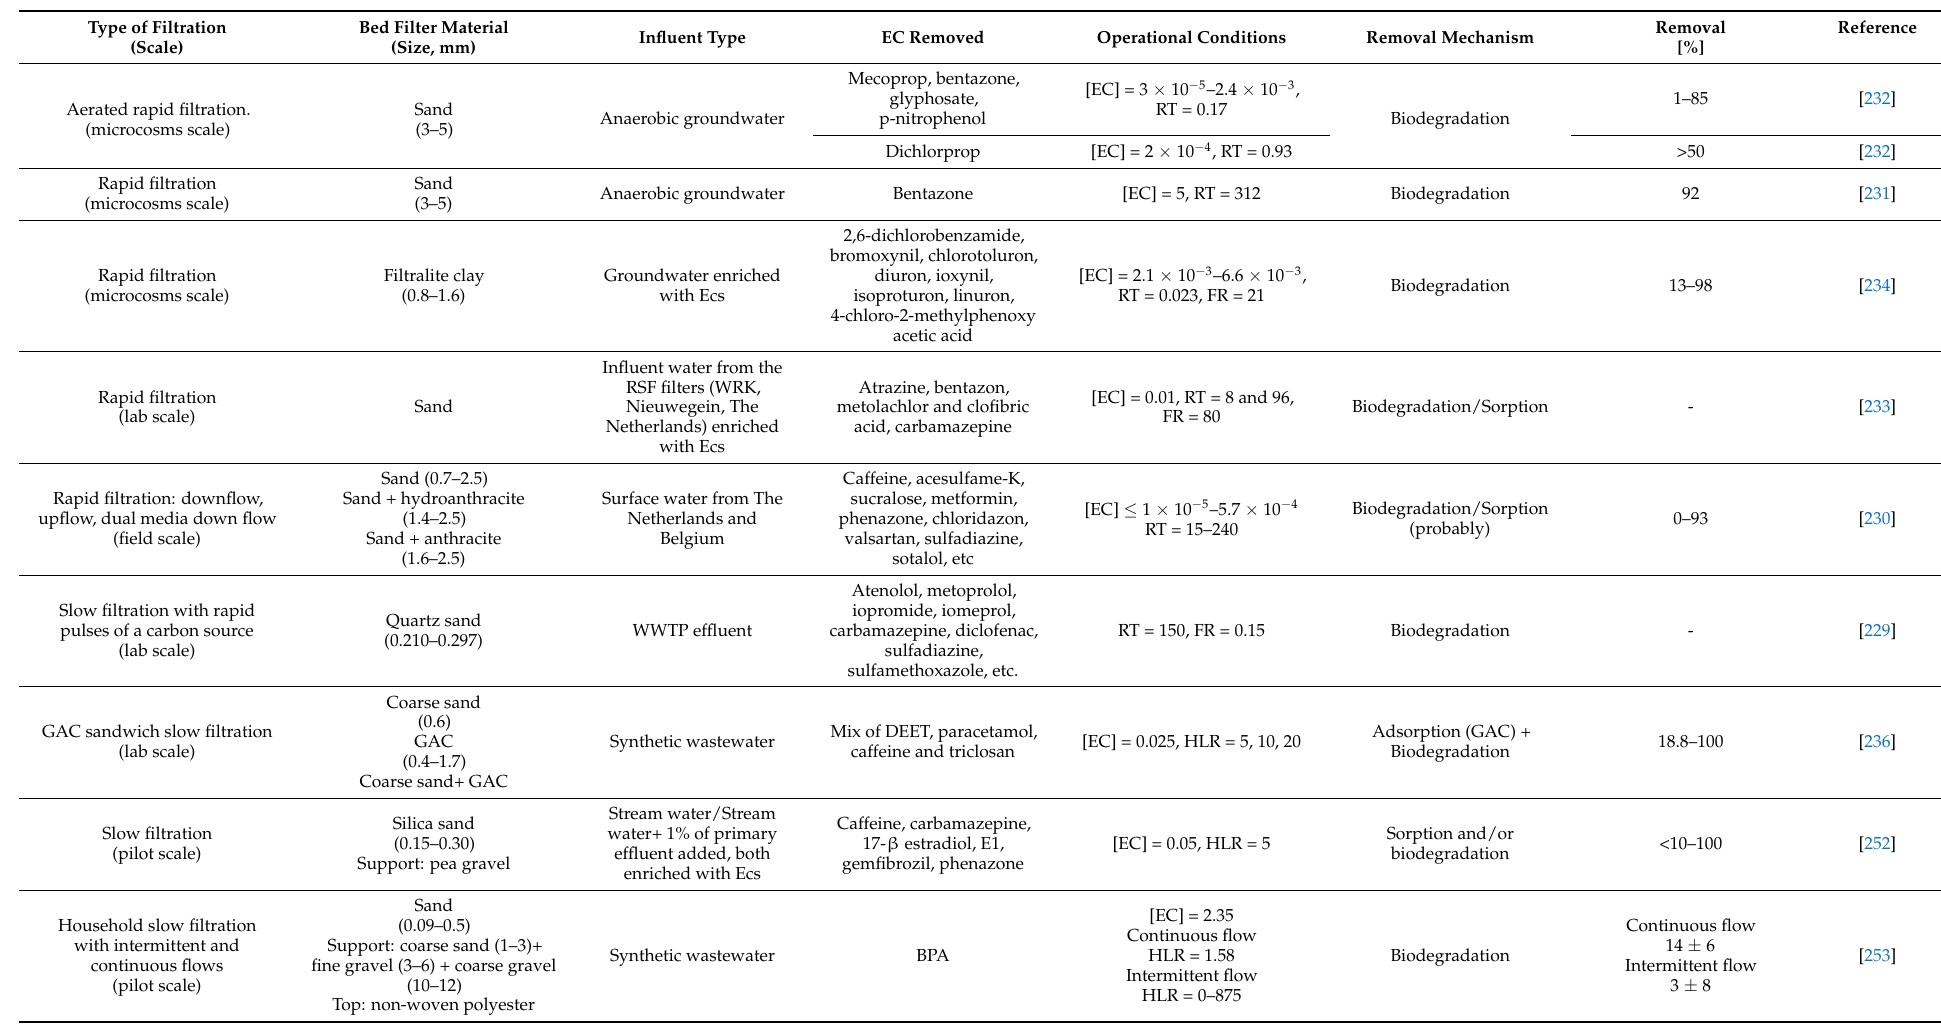
Table 6. Technologies using materials to remove ECs from